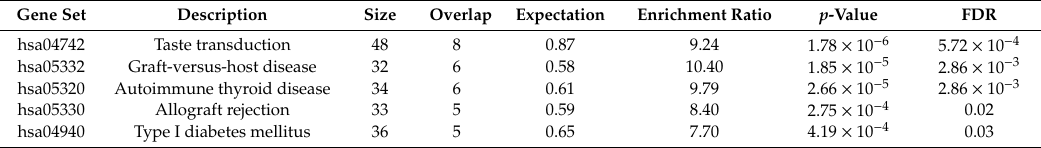
Table 2. Pathways enriched for genes with novel eQTL in the PAH